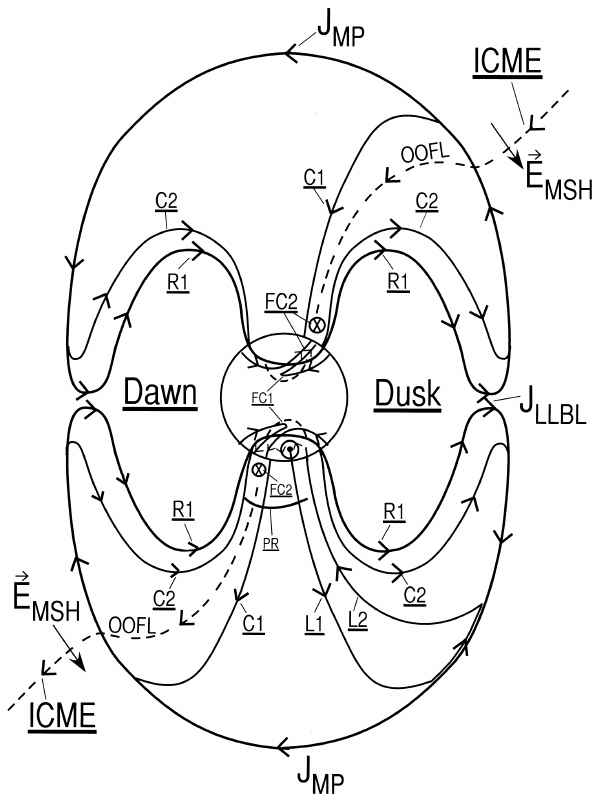
Fig. 1. A schematic illustration of the ICME-magnetosphere inter- connection topology for B y < 0 conditions and Birkeland currents current systems in the Northern (NH) and Southern (SH) Hemi- spheres relating to flow channels FC 2 ( E × B - drift) in the north (NH-dusk/ B y < 0) and south (SH-dawn/ B y < 0). The perspective is looking from the Sun towards the Earth. (North is up and Dusk is to the right). The poleward and equatorward branches of the R1 Birkeland current, connected to the outer and inner edges of the low-latitude boundary layer (LLBL), are marked C2 and R1, respectively. These Birkeland currents are connected to the mag- netopause current ( J MP ) at high latitudes via J LLBL in the LLBL and to the Pedersen current ( J P ) at the ionospheric level. The C1 Birkeland current is threaded by old open field lines (OOFL) and polar rain (PR) precipitation. Plasma flows in dawn-dusk asymmet- ric convection cells applicable to our cases are indicated: 2-cell pat- tern in north and 3-cells in the south. The lobe cell in the Southern Hemisphere (marked by circle) is favoured by the summer dipole tilt. The associated Birkeland currents are marked L1–L2. Current L1 is associated with polar arcs while current L2 is accompanied by a dropout of polar rain precipitation. The E -field/momentum coupling from the magnetosheath ( E MSH ) to the ionosphere (FC 2) along old open field lines is indicated. Flow channels FC 1 on newly open field lines (Cusp/LLBL precipitation) are also